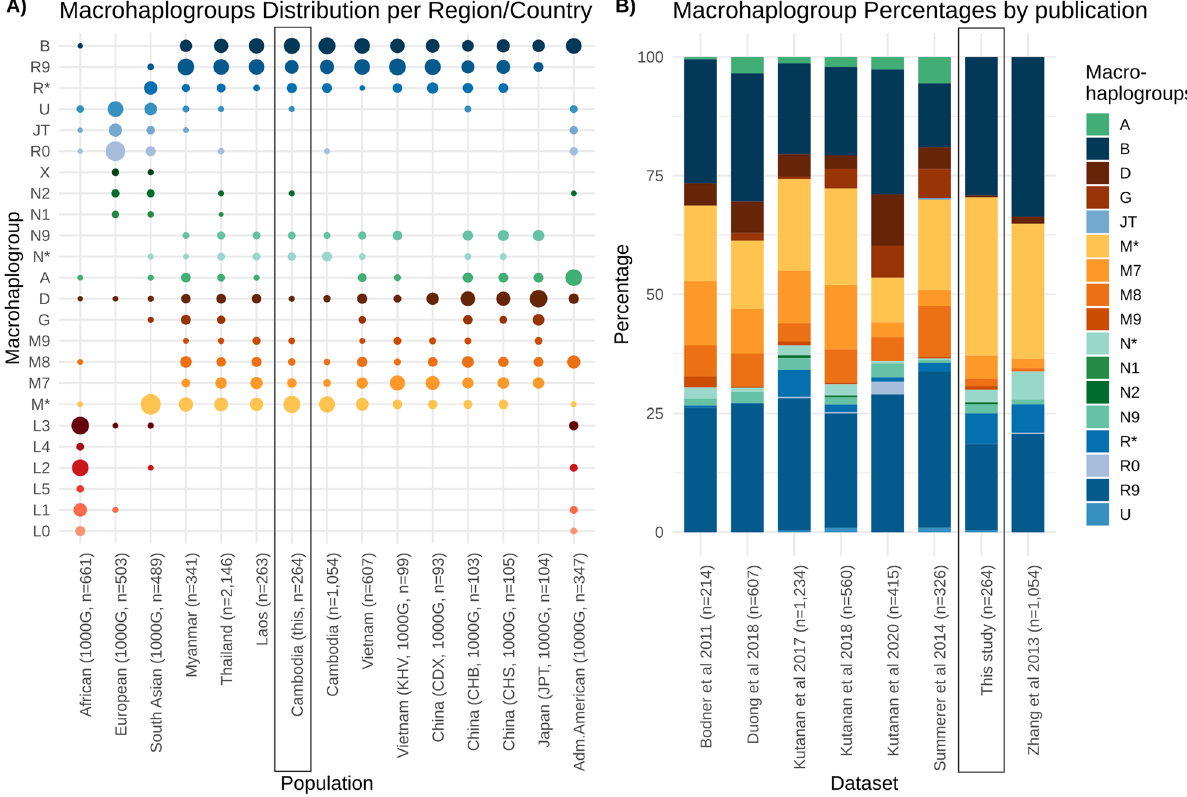
tories), which allowed the calculation of pairwise F ST values based on a dataset compiled from the complete mtDNA sequences. Supplemental Material Table S9 provides the complete dataset with 5,983 multiple aligned